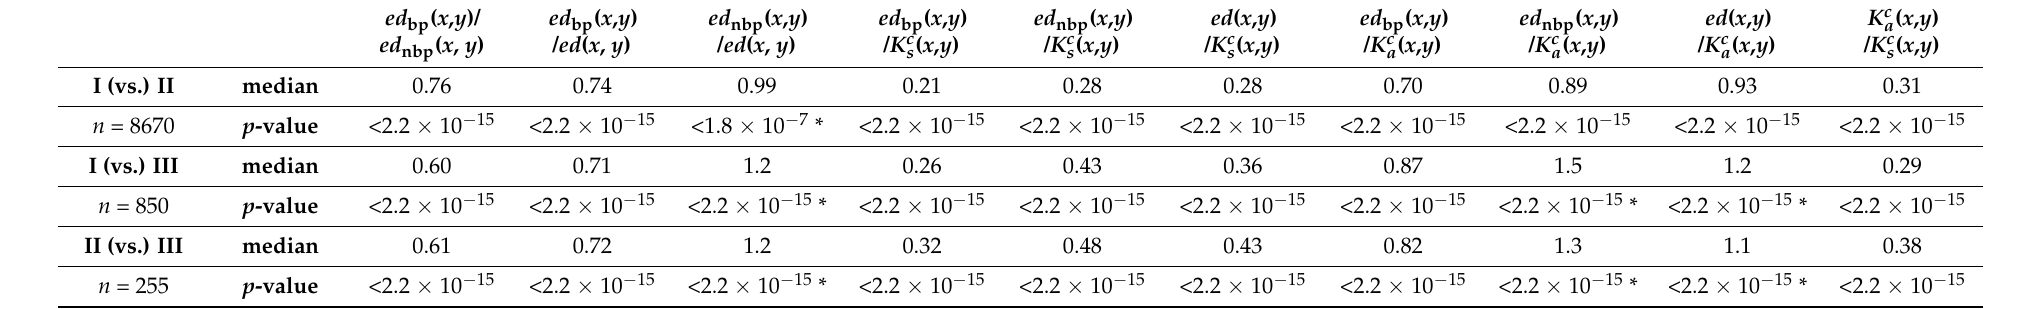
Table 4. Medians and corrected p -values of ten distance ratios between genotypes. The size of the samples of each genotype is indicated by n . See legend of Table 3 for the asterisk and the representation of the p